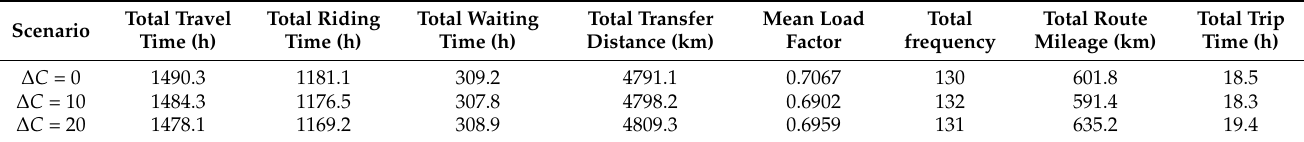
Table 7. Influence of station capacity on the proposed model